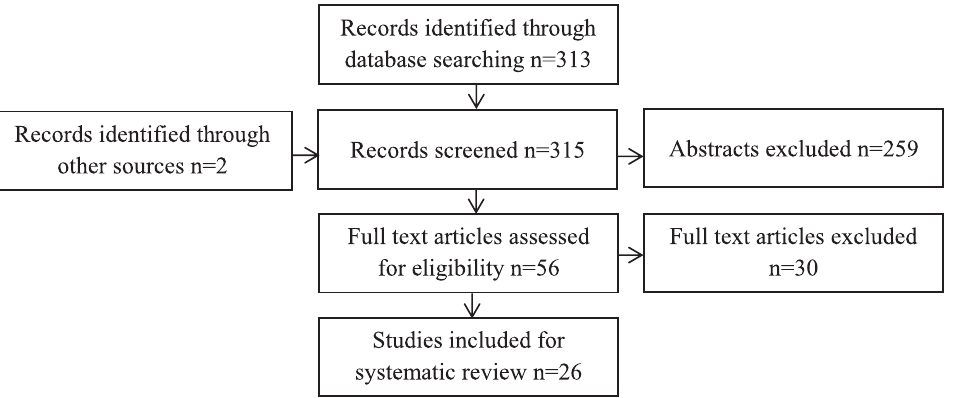
Fig. 1. Flowchart of the search strategy used in the review. The relevant number of papers at each point is provided.